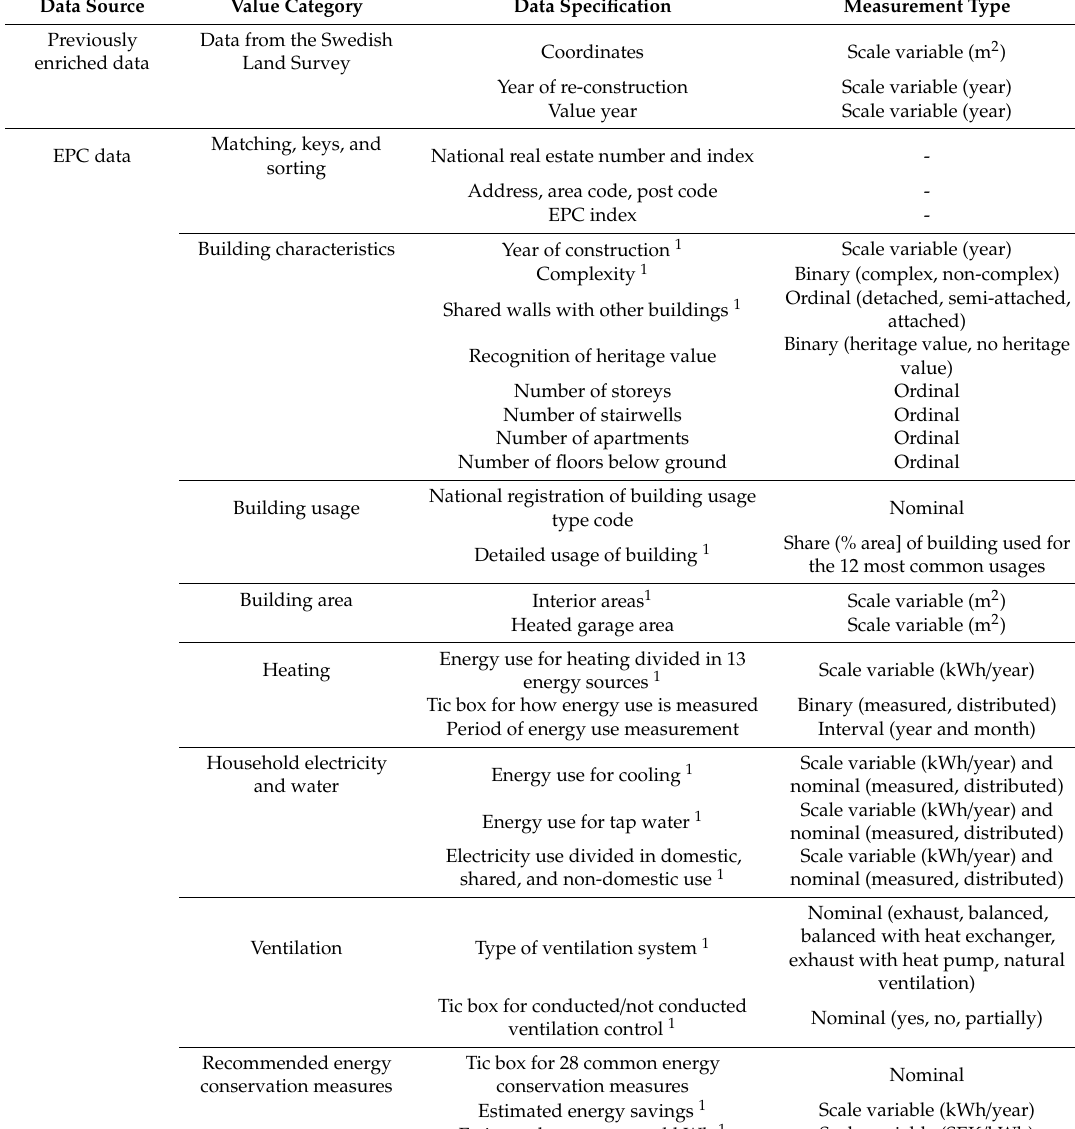
Table 1. An overview of the available data in Swedish EPCs as described by Mangold et al.